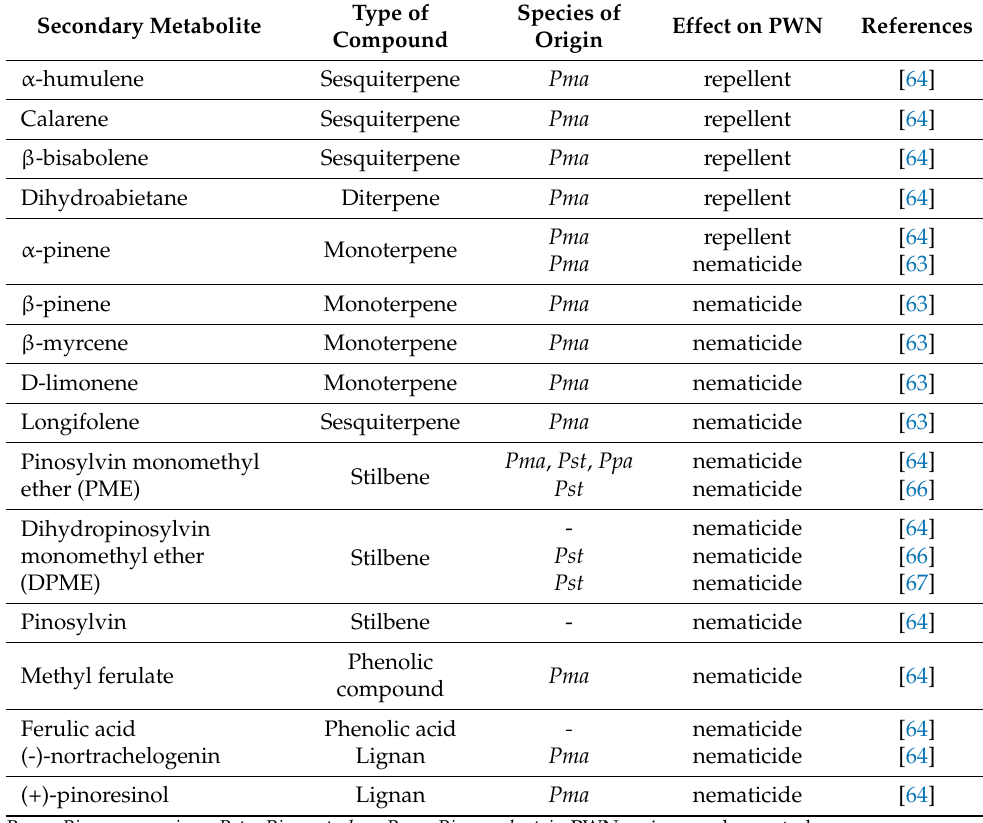
Table 2. Secondary metabolites with a toxic effect on pinewood nematode